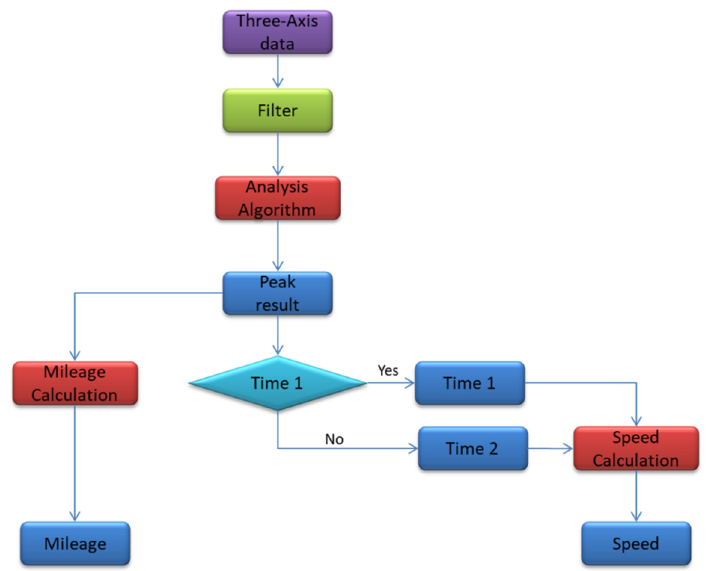
Figure 11. Mileage estimation flow.